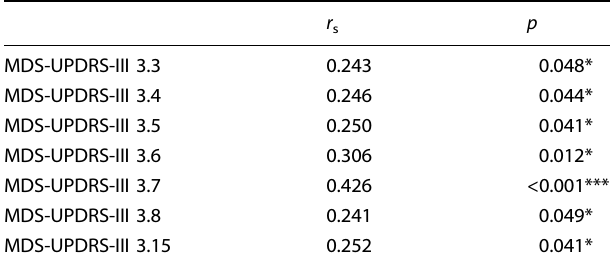
Table 2. Correlation analysis between IPA and other MDS-UPDRS-III sub-items that were signi fi cant.